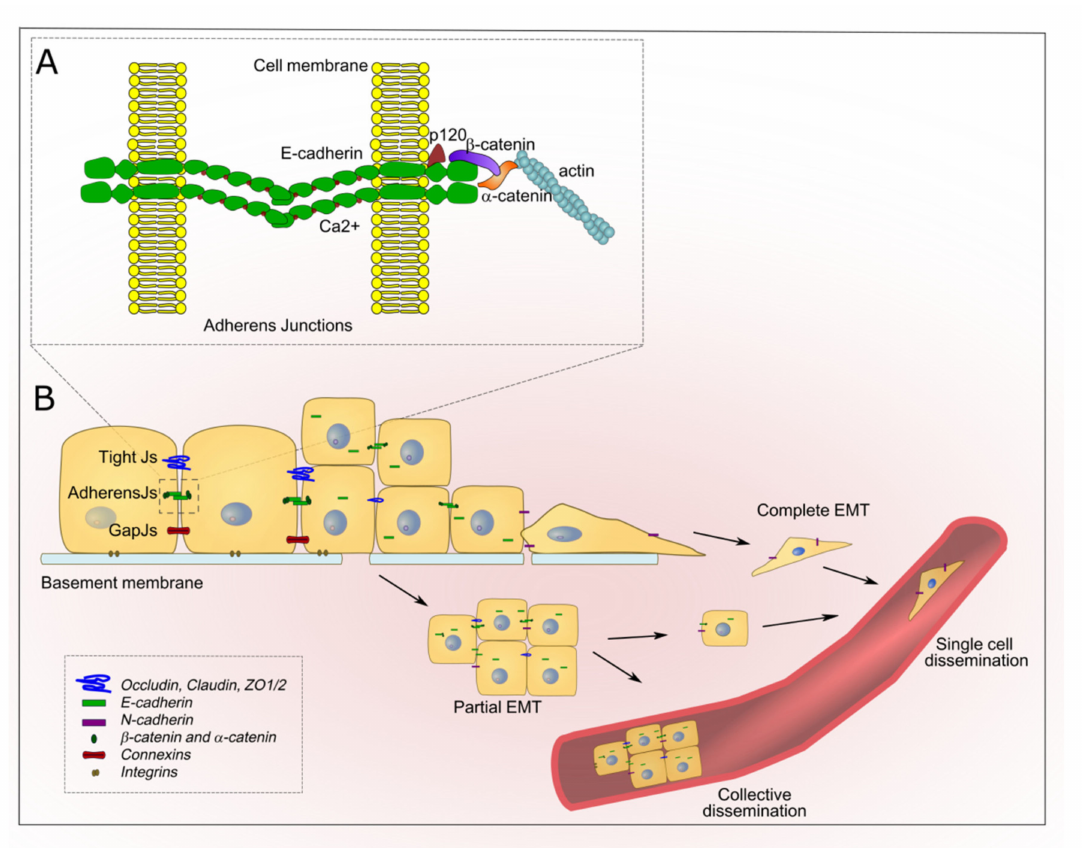
Figure 1. Epithelial tissue organization is dismantled in cancer progression. ( A ) Schematic representation of the transmem- brane protein E-cadherin and catenins at the adherens junctions (AJs). The extracellular region of E-cadherin is composed of five Ca 2+ binding domains and participates in cis and trans interactions. The intracellular juxtamembrane domain (JMD) and the carboxy-terminal domain of E-cadherin interacts with p120- and β -catenin, respectively. β -catenin, in turn, binds to the actin cytoskeleton via α -catenin. ( B ) Changes in the cell-to-cell tight, adherens, and gap Junctions (Js) occur during the transition from the normal epithelial state (left) to partial (pEMT) or complete EMT(right). Tumor cells with EMT phenotypes migrate primarily as single cells, whereas pEMT cells may disseminate by both single and collective